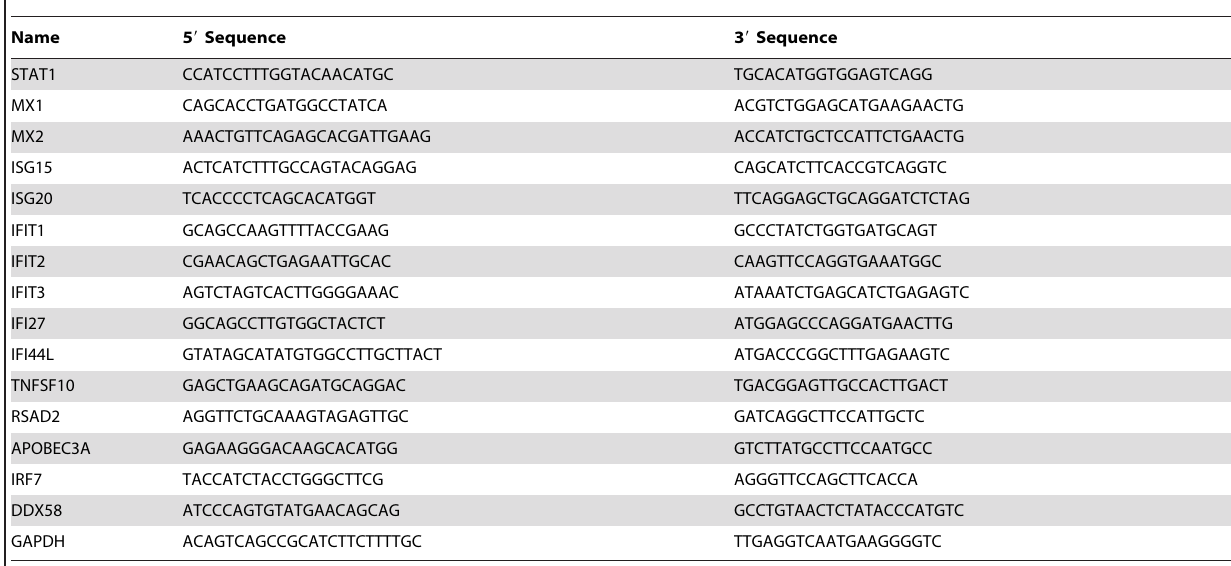
Table 2. Primers used for real-time